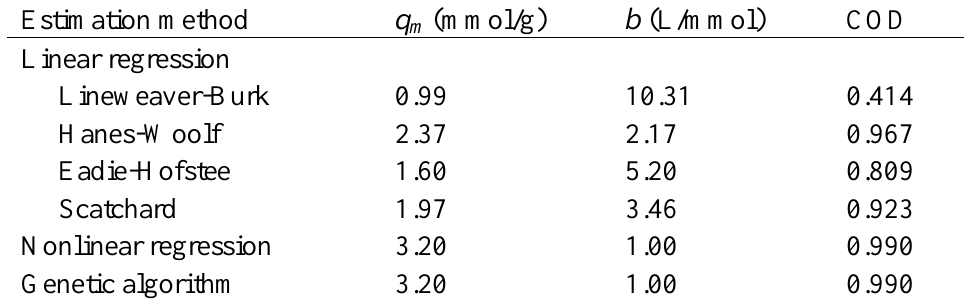
Table 2. Parameter estimation in the Langmuir equation by the linear regression, nonlinear regression and GA